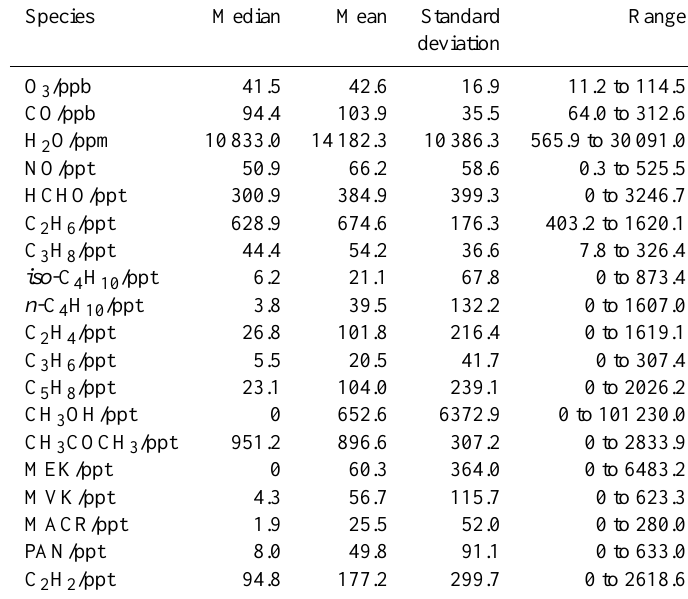
Table 2. Summary of data inputs to the model. Chemical names are those used in the